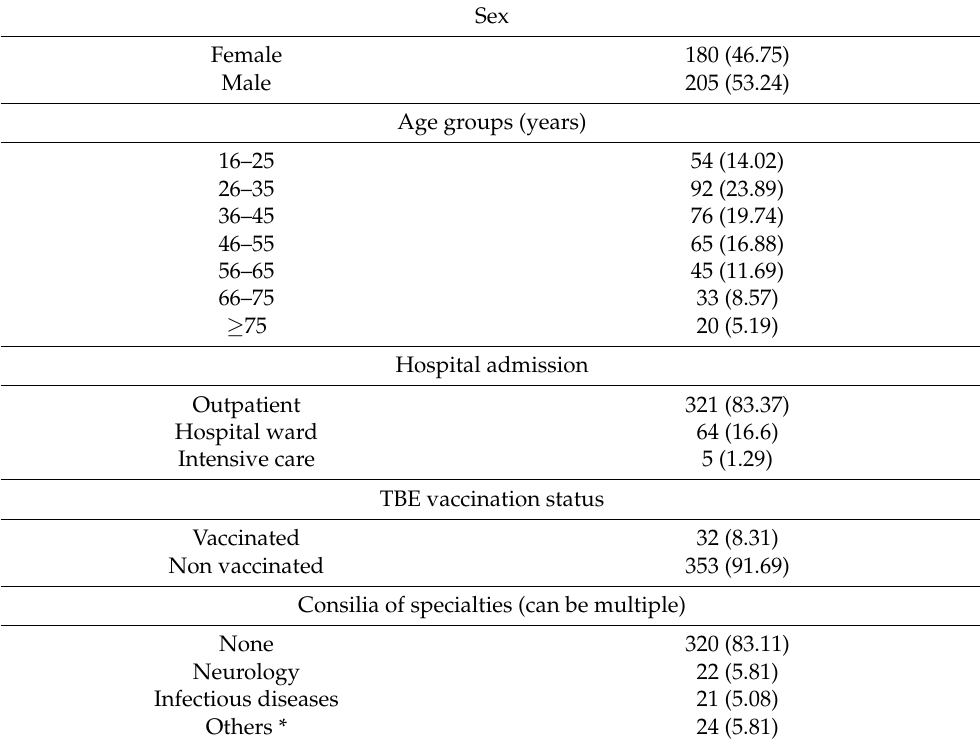
Table 1. Demographic data and patient